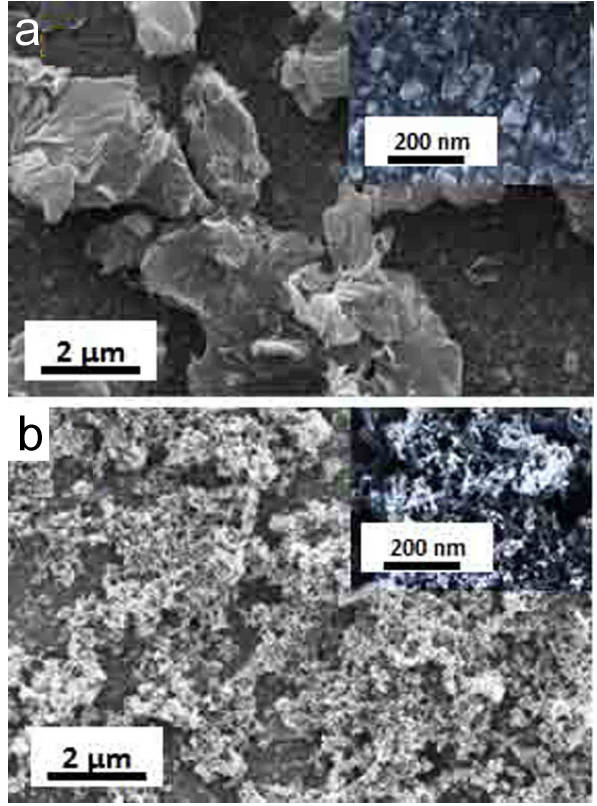
Figure 3: FESEM image analyses of a, d) MeGO; b, e) MeGO/PANI